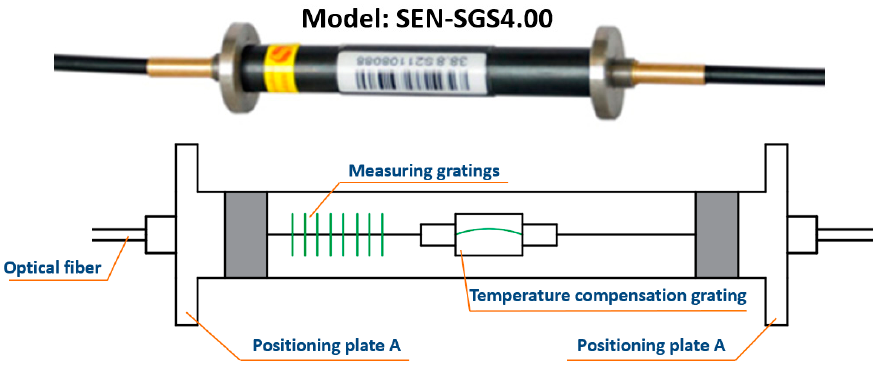
Figure 13. Model and basic structure of gauges.